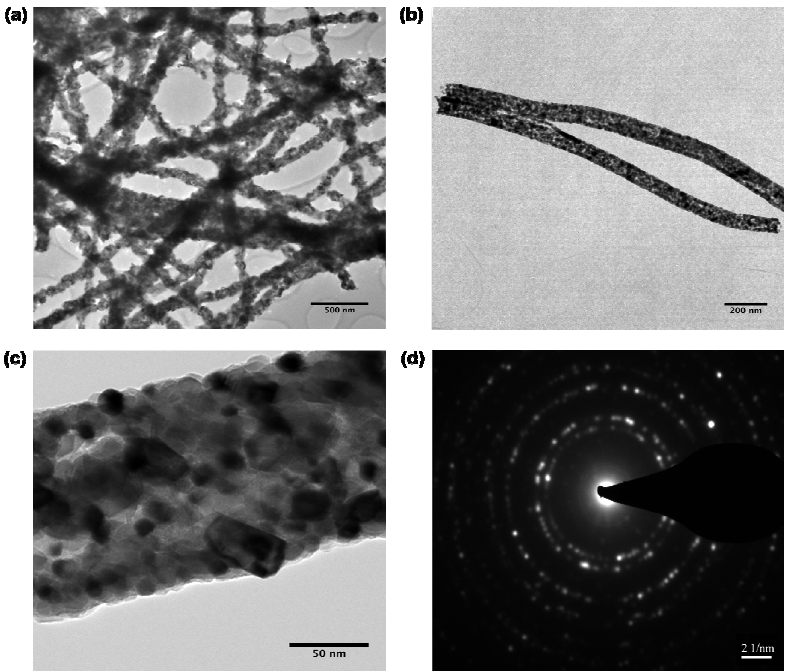
Figure 3. TEM for NiO nanofibers: ( a ) series of NiO nanofibers; ( b ) isolated pair of NiO nanofibers at ( c ) individual nanofiber; ( d ) selected area electron diffraction (SAED) pattern of